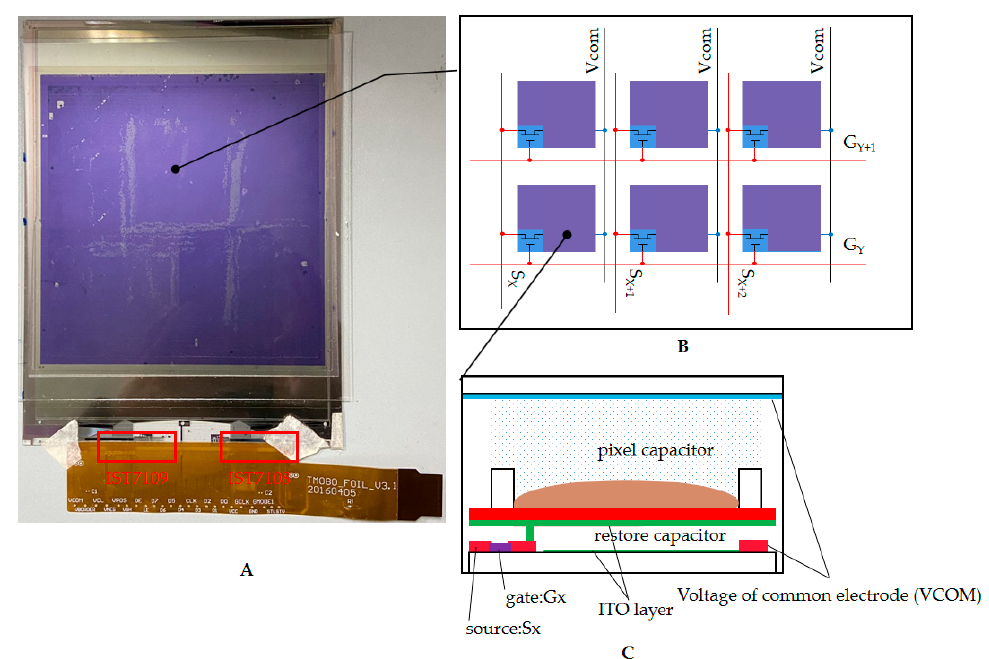
Figure 2. An active matrix EWD panel. ( A ) The appearance of the EWD module. The voltage of each pixel is precisely controlled by a scanning sequence composed of source and gate chips. ( B ) Equivalent circuit of a TFT substrate. Each pixel is controlled by a TFT for charging and discharging. The time-division multiplexing of the source signal is realized by the TFT array. ( C ) Cross-section views of a pixel and a TFT substrate. The voltage of the storage capacitor is controlled by the TFT so that continuous energy can be provided by the storage capacitor for the oil to maintain the state during the row and column scanning.